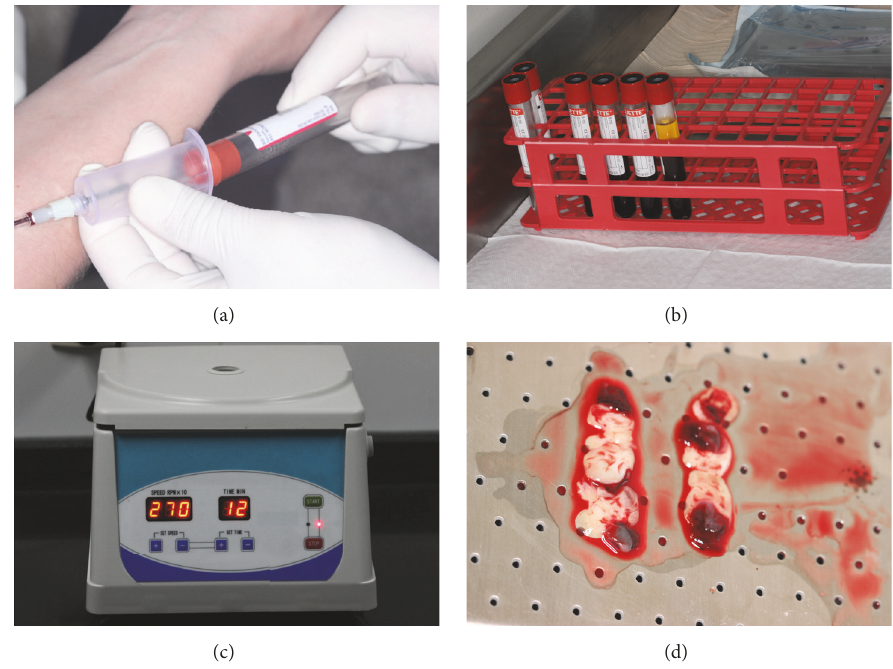
Figure 2: (a) Blood collection. (b) Blood stocking tubes. (c) Centrifugation. (d) Platelet-rich fibrin membranes.